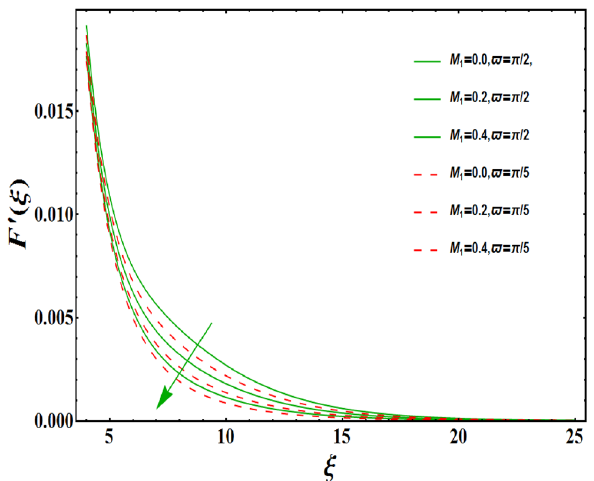
Figure 5. Variation of M 1 on F ′ (ξ) for both with and without inclanation.